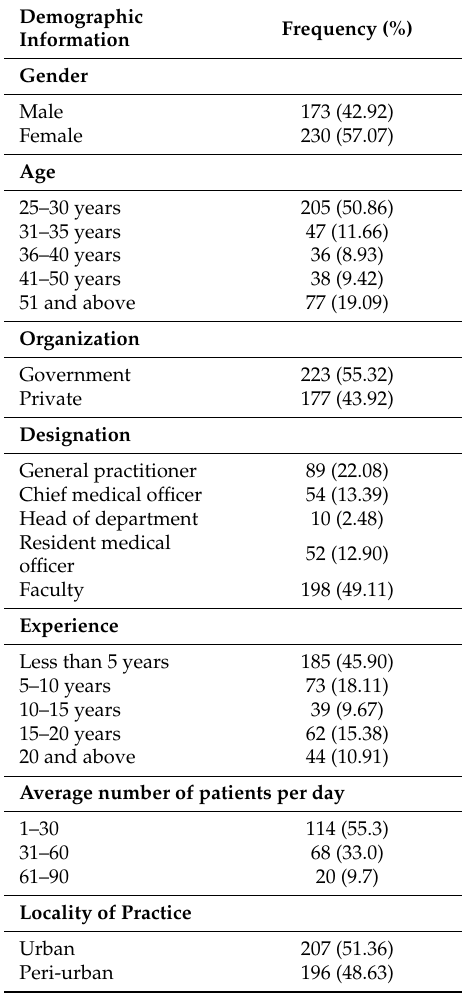
Table 1. Demographic information of respondents.